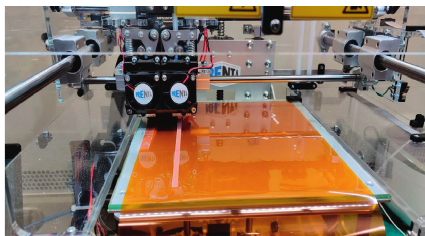
Figure 1: 3D printing of the TRF filament on polyamide film.